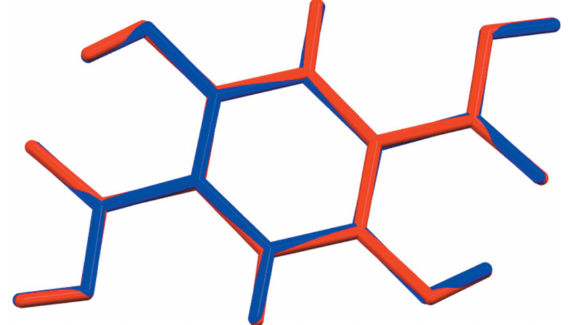
Figure 2 Comparison of the Rietveld-refined (red) and VASP -optimized (blue) structures of anhydrous 2,5-dihydroxyterephthalic acid. The r.m.s. Cartesian displacement is 0.053 A˚ . Image generated using Mercury (Macrae et al. , 2020).